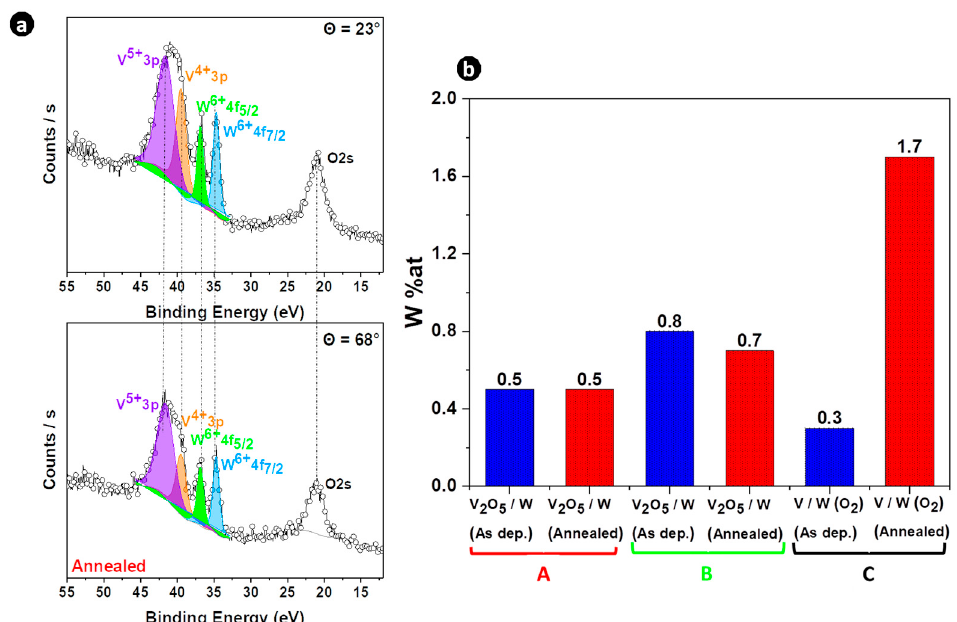
Figure 4. ( a ) Fitted ARXPS spectra of V 3p, W 4f, and O 2s core-levels for sample C after thermal annealing, at detection angles of 23° and 68°. ( b ) Quantification of W based on O 2s, W 4f, and V 3p peaks of the different samples before and after rapid thermal annealing.